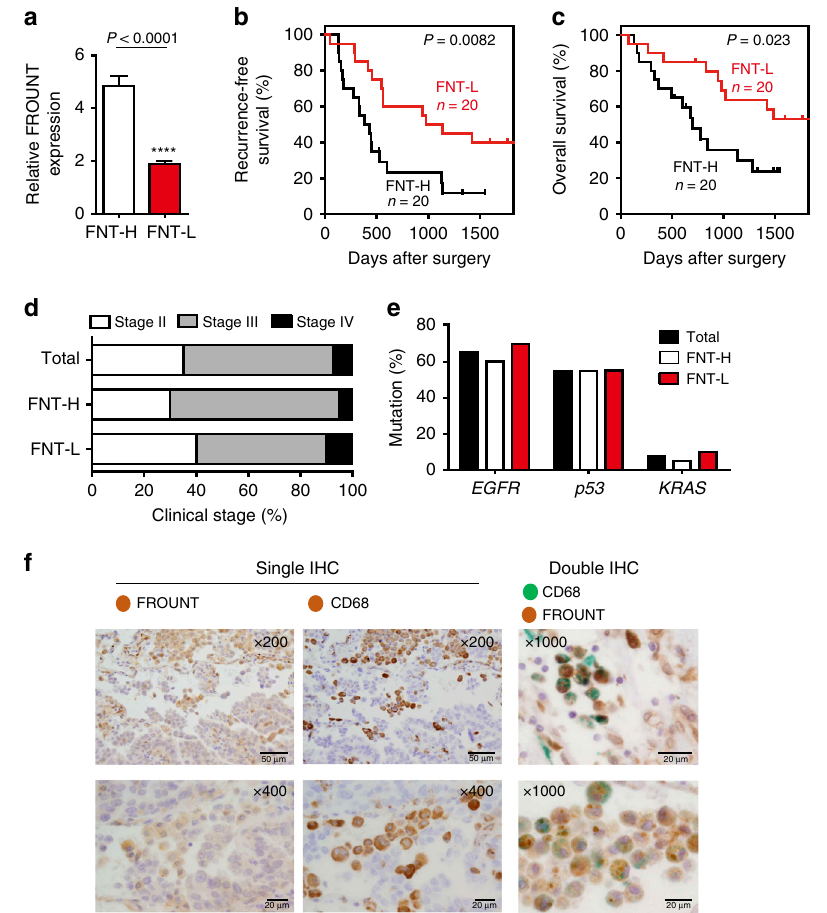
Fig. 1 FROUNT expression is a risk factor for poor prognosis in patients with lung cancer. a FROUNT expression was measured in total RNA isolated from tumor specimens and patients were divided into FROUNT -high ( n = 20) and FROUNT -low groups ( n = 20). b , c Survival analysis of FROUNT -high (FNT-H) and -low (FNT-L) patients with lung cancer. Recurrence-free ( b ) and overall survival curves ( c ). d – e Clinical stages ( d ) and the prevalence of EGFR , p53 , and KRAS mutations ( e ) were comparable between FNT-H and FNT-L groups. f Immunohistochemistry (IHC) of FROUNT and CD68 (brown), and double IHC of FROUNT (brown) and CD68 (green) in human lung adenocarcinoma. Representative images of tumors of a patient among 30 patient samples tested. Scale bars, 20 μ m. **** P < 0.0001 by two-tailed, unpaired Student ’ s t -test. Error bars indicate